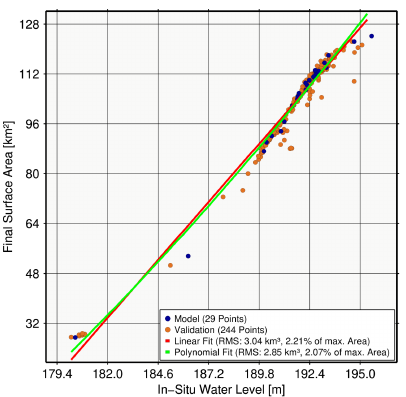
Figure 15. Relation between water level and surface area (hypsometry) used for cross-validation at Lake Ray Roberts. The blue points (10% of all points) are used for the function fitting, the orange points for the validation. The two fitted curves are plotted in red (linear fit) and green